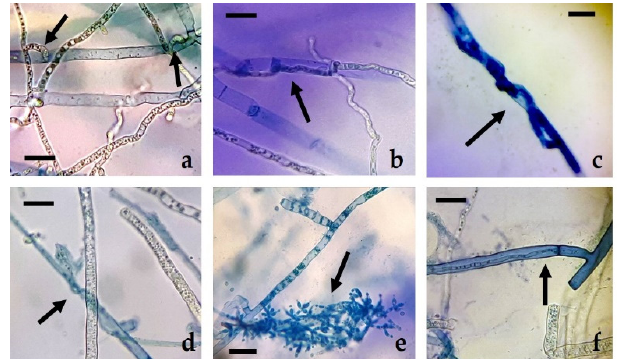
Figure 2. Hyphal interactions of T. harzianum with R. solani in dual plate confrontations: ( a ) pene- tration structures; ( b ) appressorium; ( c , d ) coiling hyphae; ( e ) sporulation; ( f ) intracellular growth. Bars = 10 µm.